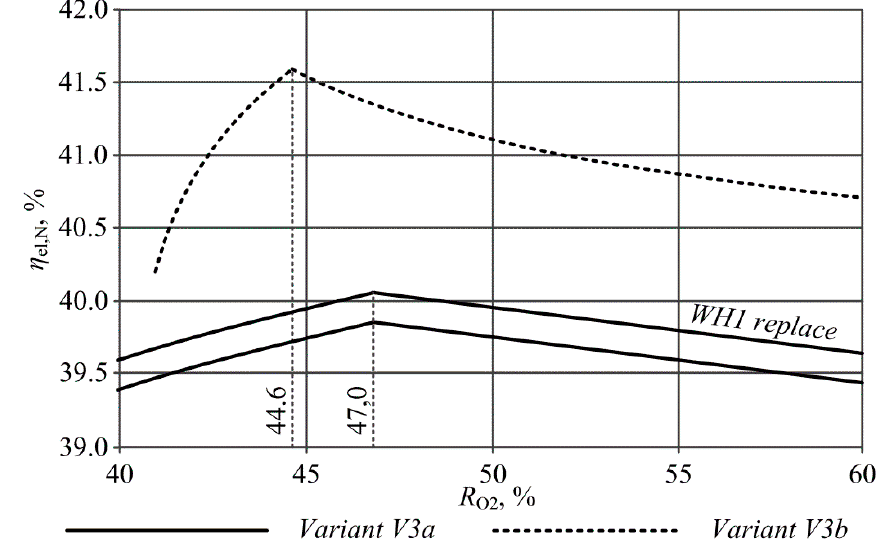
Figure 19. Net e ffi ciency of electricity generation as a function of the oxygen recovery Figure 19. Net efficiency of electricity generation as a function of the oxygen recovery rate.